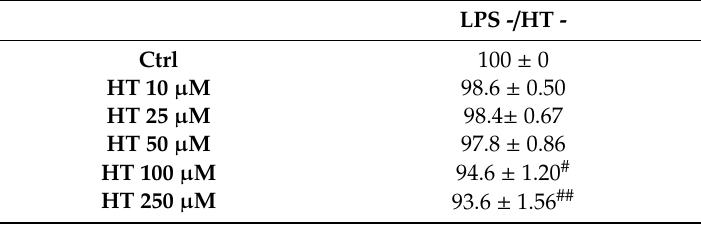
Table 1. E ff ects of HT on BEND cells viability.